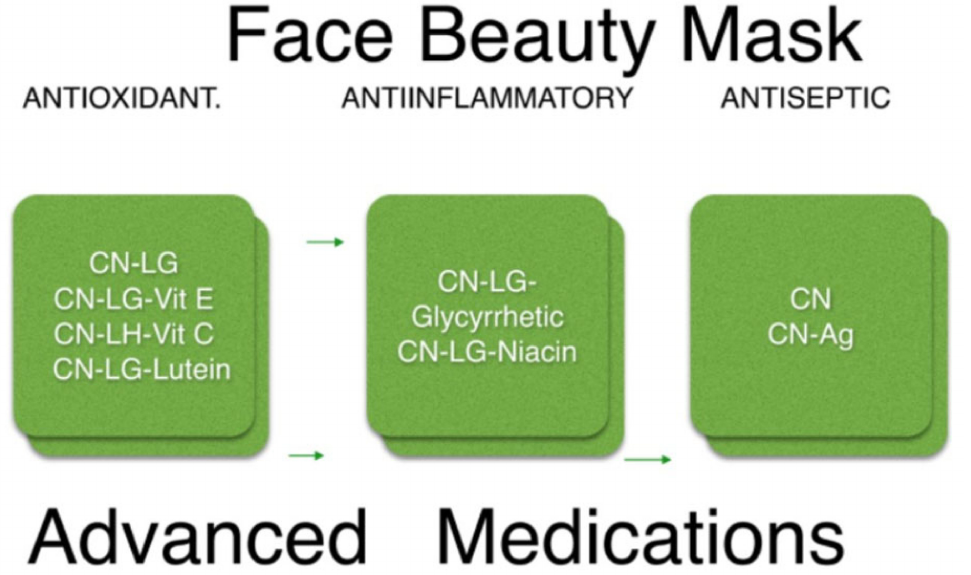
Figure 10. Effectiveness of various active ingredients encapsulated into CN–LG micro capsules bound to the fibers of beauty masks and surgical